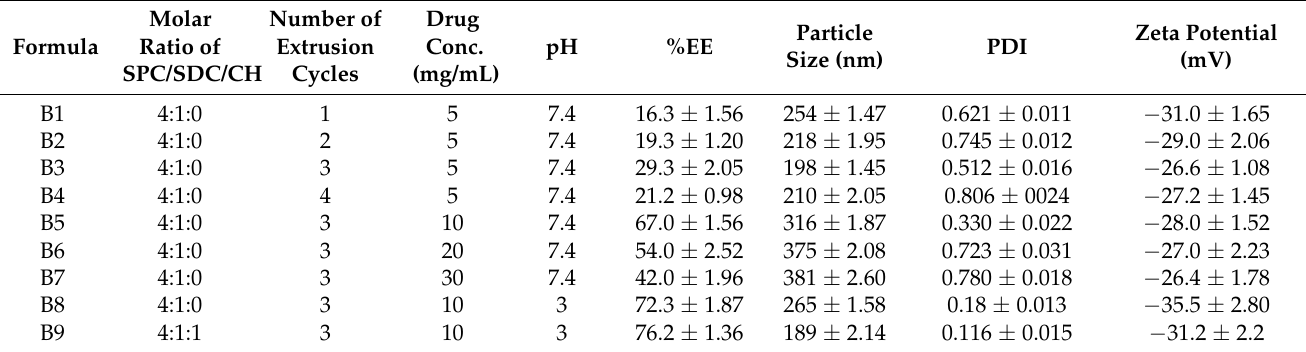
Table 1. The composition and physicochemical characterization of different RES-loaded